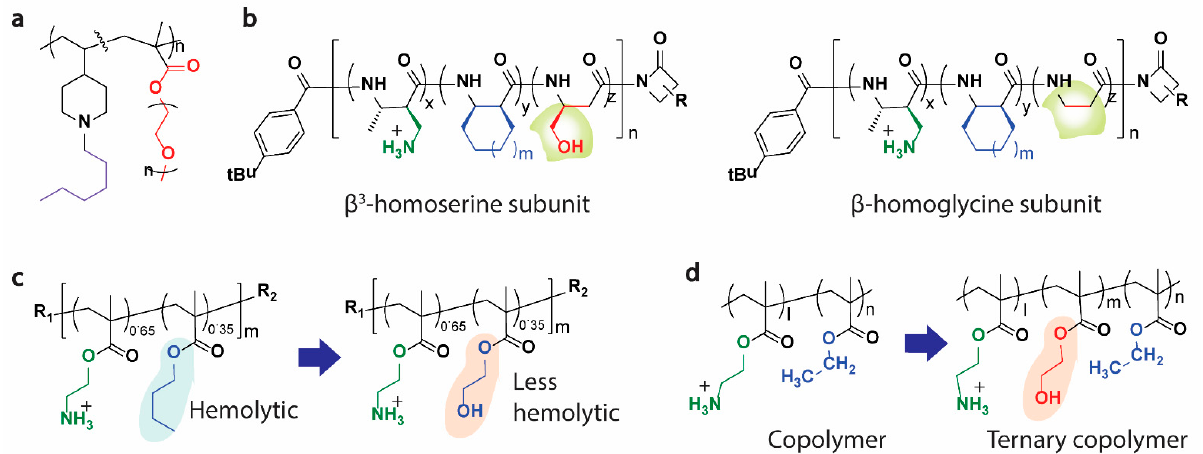
Figure 5. Ternary HDP-mimicking polymers. The introduction of neutral/hydrophilic groups/spacer, as shown, led to a significant reduction in hemolysis. ( a ) Poly-norbornene polymer incorporated with PEG [97], ( b ) introducing polar or uncharged units to the nylon-3 copolymers [98], ( c ) replacement of hydrophobic group with a hydrophilic group in a methacrylate-based polymer [99] and ( d ) introduction of a polar group as a spacer between the cationic and hydrophobic subunit of a methacrylate-based antimicrobial polymer [102].